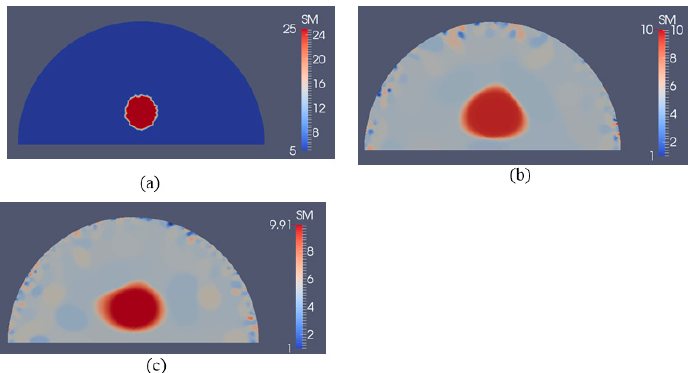
Figure 9. Shear modulus reconstructions with 1% noise. ( a ) target shear modulus distribution with varied inclusion depth in comparison to previous target problem domain in Figure 4a,b; ( b , c ) reconstructed shear modulus distribution using 5 and 10 boundary displacement data sets, respectively (unit in the scale bar: kPa). Note: “SM” stands for shear modulus. Sensors 2017 , 17 , 1075